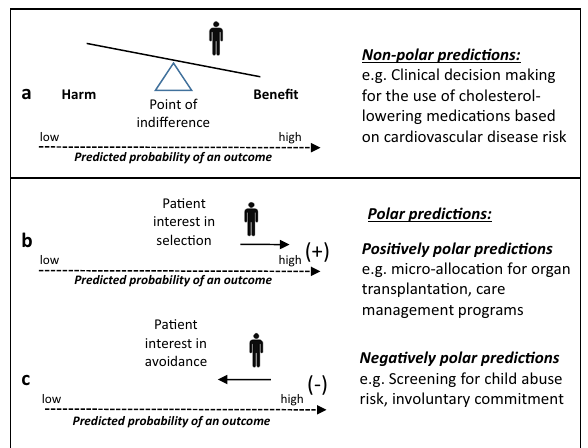
Fig. 2 Non-polar and polar prediction-supported health care decisions. Understanding the speci fi c decisional context of a prediction-supported decision in healthcare is necessary to antici- pate potential unfairness. In the medical context — particularly in the shared decision-making context — patients and providers often share a common goal of accurate prognostication in order to help balance bene fi ts and harms for care individualization. Predictions supporting decisions in this context may be described as “ non- polar ” ( a ). On the other hand, when one “ pole ” of the prediction is associated with a clear bene fi t or a clear harm, predictions may be described as “ polar ” in nature. In cases of polar predictions, the decision maker ’ s interest in ef fi cient decision making (i.e. based on accurate prognostication using all available information) is not aligned with the subject ’ s interest to have either a lower (e.g. screening for abuse risk) or higher (e.g. microallocation of organs) prediction. “ Positively ” polar predictions correspond to those where patients may have an interest to be ranked high to receive a service that may be available only to some of those who can potentially bene fi t ( b ). This is in distinction to “ negatively ” polar predictions, in which prediction is used for the targeting of an